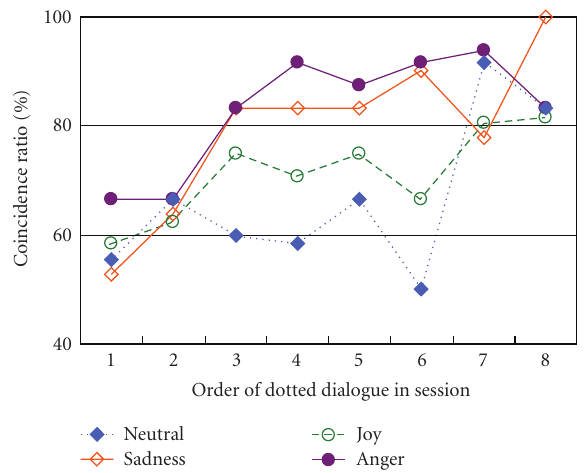
Figure 24: Change of coincidence ratio as a function of emotions and order of dotted dialogue in session.